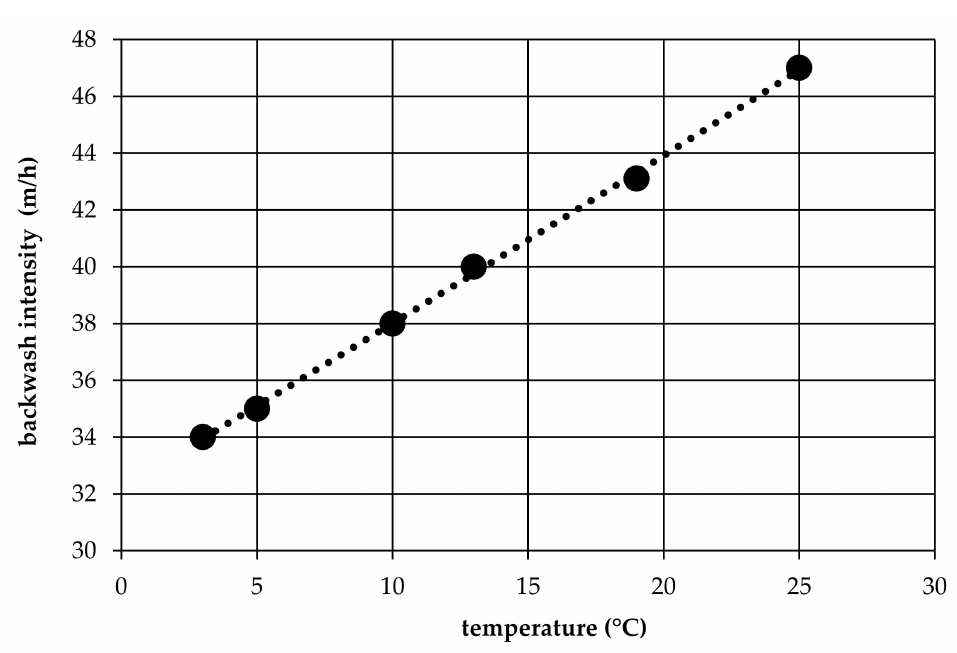
Figure 7. Intensity of rapid filter backwashing for 25% expansion, as a function of